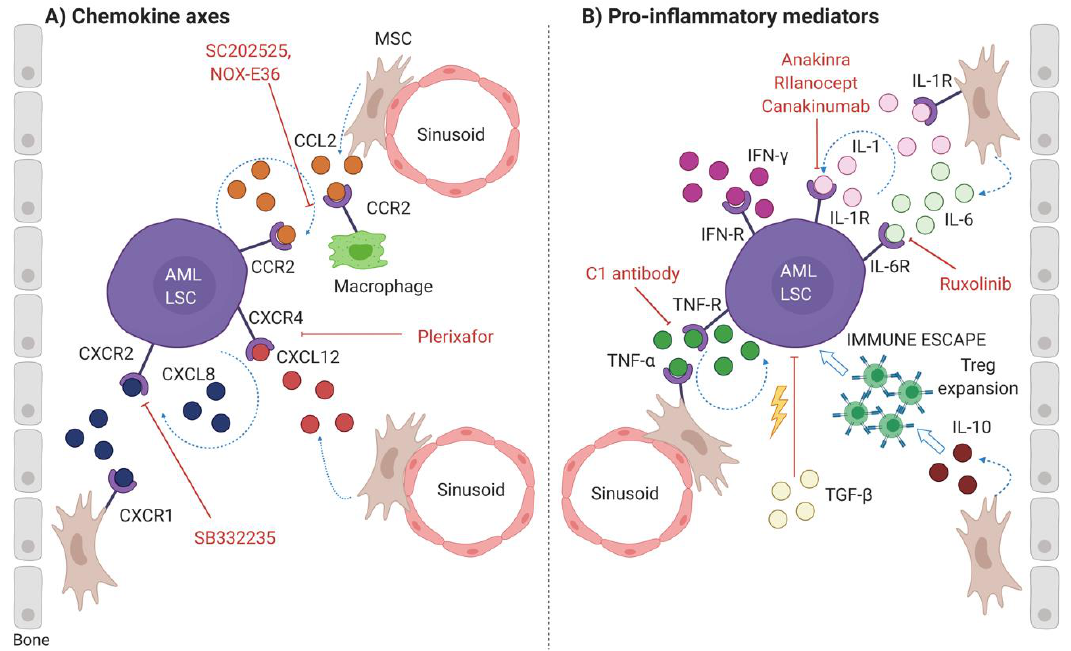
Figure 2. Soluble mediators involved in AML-BM niche crosstalk. ( A ) Chemokines contribute to cell proliferation, survival and chemotaxis. All these functions are important for the development of the AML-supportive BM niche. The chemokine axes involved in AML are the well-known CXCL12 / CXCR4 axis and the newly investigated CCL2 / CCR2 and CXCL8 / CXCR1-CXCR2 axes. The most significant therapeutic agents and the pre-clinical molecules are outlined (red). At present,